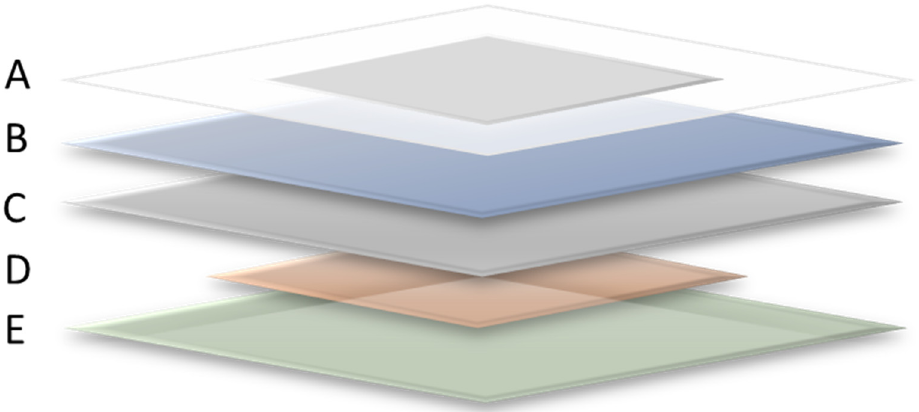
Figure 3. General design of the majority of bandages, A: Delivery Method. A paper-based skeleton for improving the on-skin application (product- and company-dependent). B: Baking. Acts as the spine of the bandage with additional roles such as that of a protective barrier against fluids, microorganisms and other impurities; it keeps the wound under moisture balance for optimal healing. C: Adhesive film. Enables gentle conformability to the skin; silicon or acrylic adhesives are commonly used. Important for keeping the dressing in place. D: Absorbent layer. Absorbs the excess of fluids, exudate, and impurities from the wound surface. E: Release liner. Low-friction film, released before application. Bandages may come in many forms such as foam, nonwoven materials, absorbent fi bers and more. The main structure is the combination of layers B, C and D.